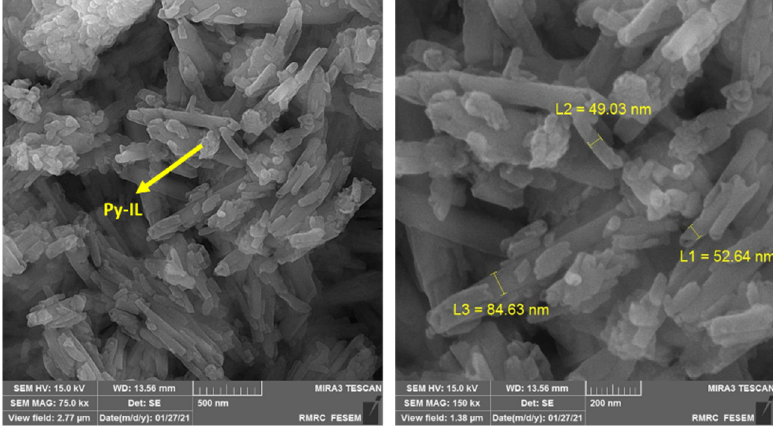
Figure 2 . SEM images of Hal-Py-IL.